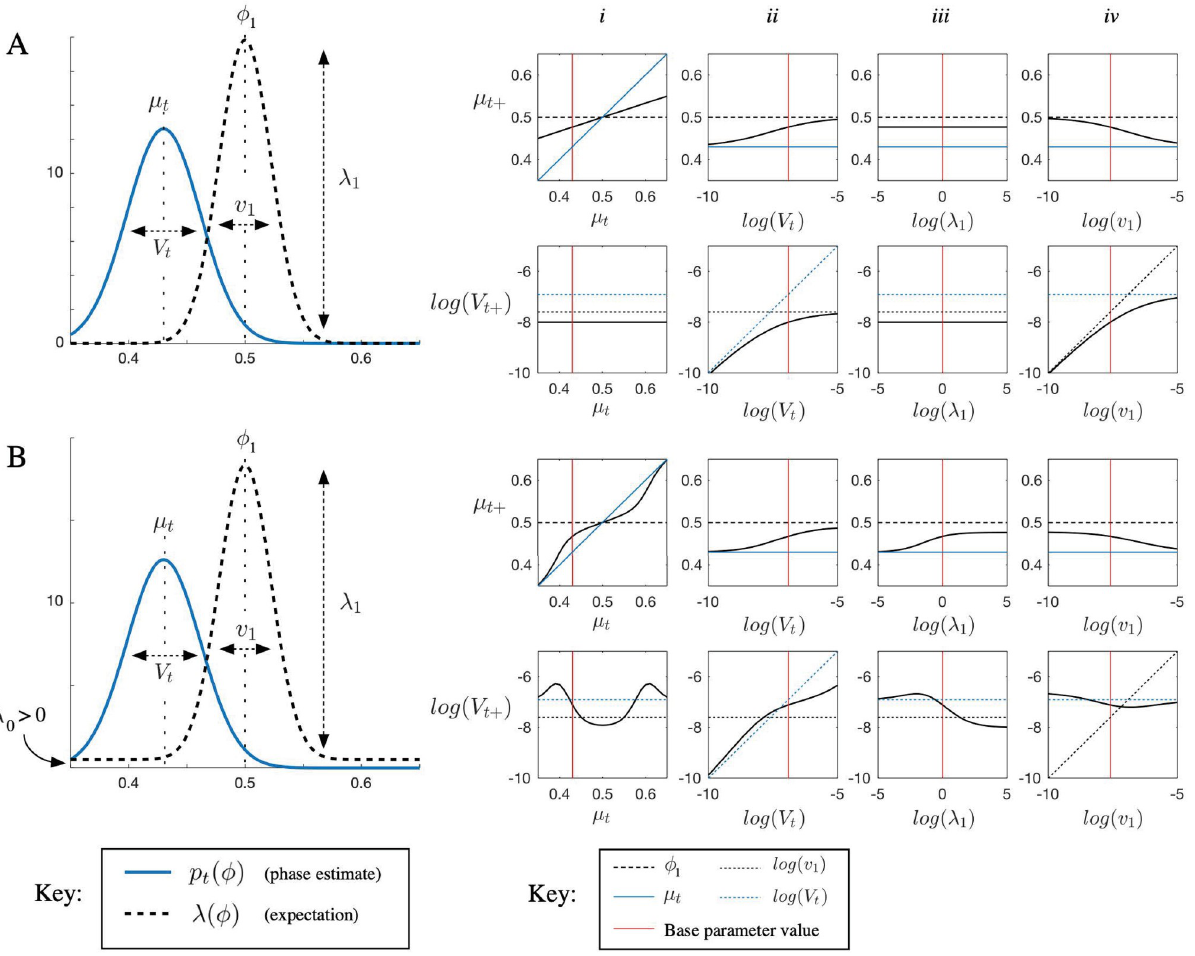
Fig 2. Characterizing PIPPET’s behavior at events. A) An event is expected at phase ϕ 1 = 0.5 with variance v 1 and expectation strength λ 1 . The expected background event rate is set to λ 0 = 0. An event occurs when the phase estimate is at μ t with uncertainty V t . Panels in columns i - iv show the resulting mean μ t + and variance V t + of the posterior on phase as the parameters μ t , V t , λ 1 , and v 1 are varied. i ) μ is corrected linearly toward ϕ 1 , while V is large. iii ) These corrections do not depend on λ 1 . iv ) decreases uniformly regardless of initial phase. ii ) Corrections to μ are more thorough when V t These corrections are more thorough for smaller v 1 . B) The same simulations are carried out with background event rate λ 0 = 0.5. i ) If μ t is close to ϕ 1 , it is linearly corrected toward ϕ 1 and V decreases; if it is far, no correction is made. In the liminal zone, V increases due to the ambiguity of whether the t t event was related to the expectation peak or due to the background source. ii ) V t + is larger due to the effect of ambiguity as to whether the event is associated with ϕ 1 or with the background rate. iii ) Now the correction depends on λ 1 : stronger expectations make this peak the favored cause relative to the background source. iv ) Note that if the expectation peak is extremely narrow, V t + may still be large after the event and μ t may not fully reset to ϕ 1 due to the aforementioned causal